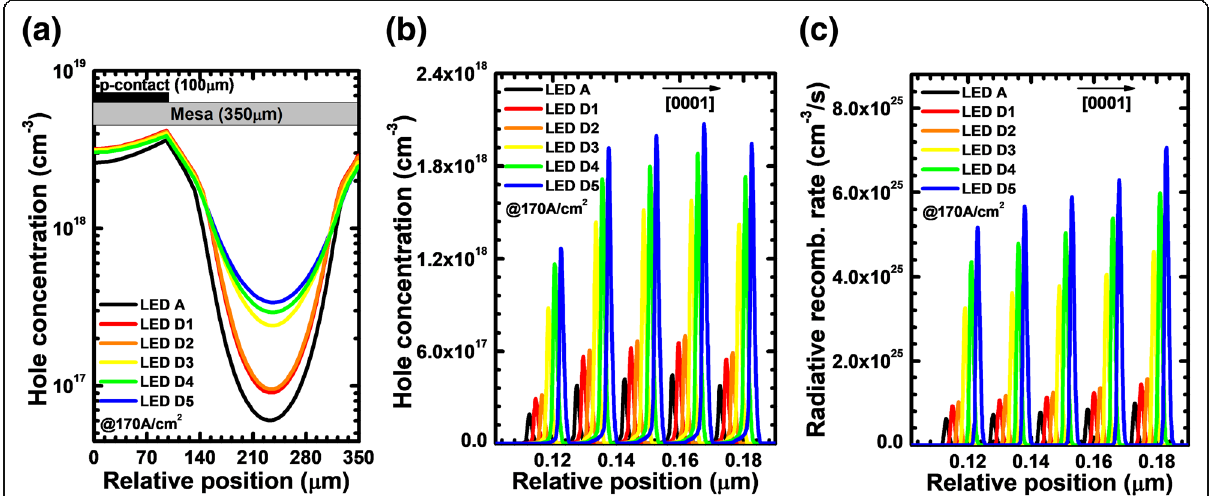
Fig. 9 a Lateral hole distribution in the last quantum well, b hole concentration profiles, and c radiative recombination rate profiles in the MQW region or LEDs A, D1, D2, D3, D4, and D5 at the current density of 170 A/cm 2 . The plotted curves for panels b and c are purposely shifted by